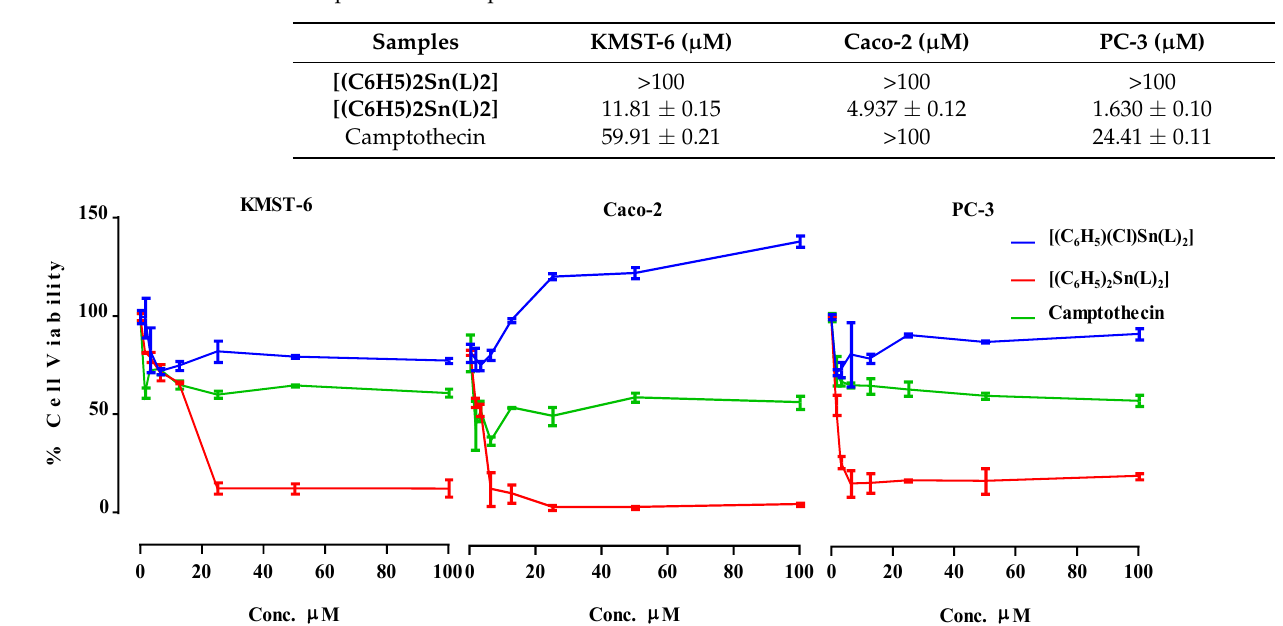
Molecules 2022 , 27 , x FOR PEER REVIEW Figure 3. Cytotoxicity of the phenyltin(IV) complexes: [(C6H5)2Sn(L)2] and [(C 6 H 5 )(Cl)Sn(L) 2 ], on cancer and non-cancer cells. Cell viability (%) was assessed by means of MTT assay after 24 h.